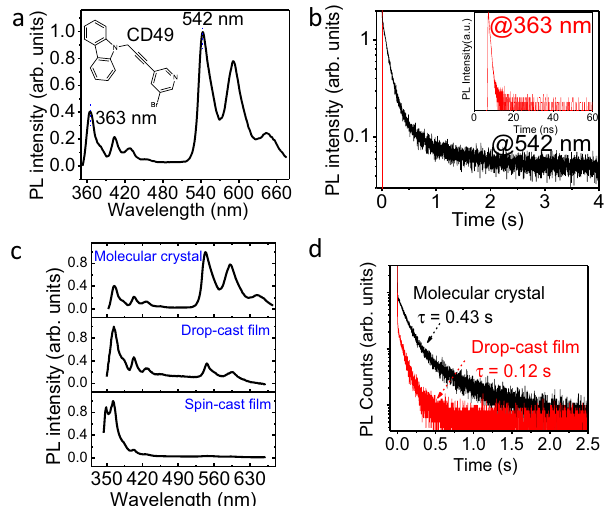
Fig. 1 PL characteristics for crystal, drop-cast fi lm, and spin-cast fi lm (CD49). a PL spectra measured from CD49 molecular crystal under 325 nm laser excitation (Inset: chemical structure for CD49). b PL decay dynamics for short-wavelength PL peaked at 363 nm and long-wavelength PL peaked at 542 nm. PL lifetime was fi tted with exponential decay equation, the average lifetime was calculated by the equation: τ and spin-cast fi lm. d PL decay dynamics for CD49 molecular crystal and drop-cast fi